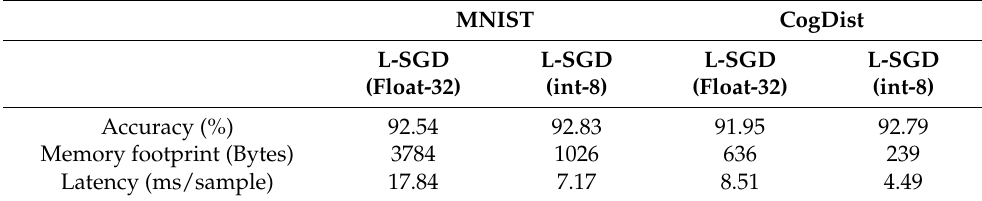
Table 7. L-SGD (float-32) vs. SGD